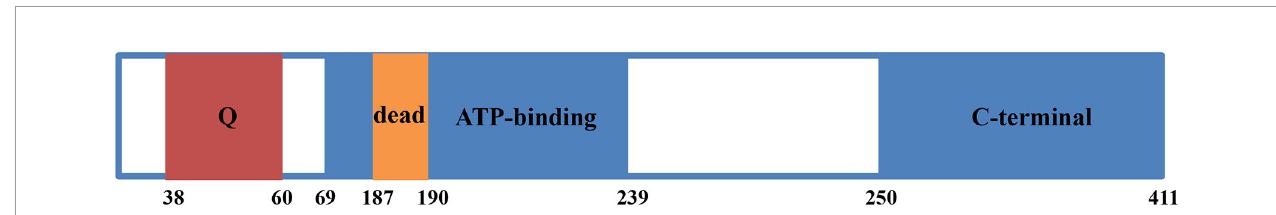
FIGURE 1 | Diagram of EIF4A3 protein structure. EIF4A3 consists of 411 amino acids, with a Q motif at positions 38-60, a DEAD box motif at positions 187-190, a helicase ATP-dependent domain at positions 69-239, and a helicase C-terminal domain at positions